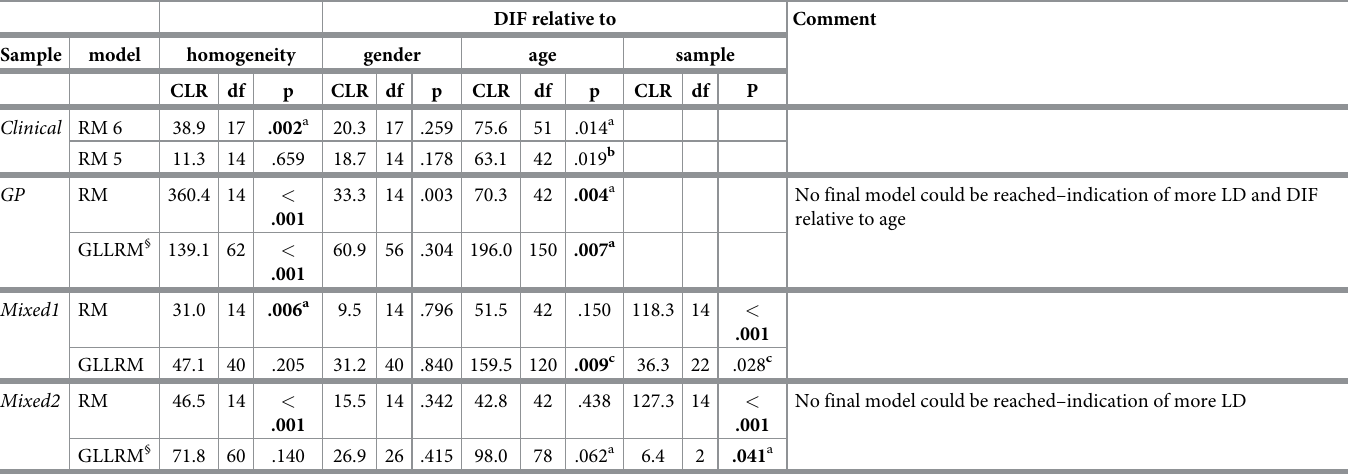
Table 5. TB-subscale (4 response categories): Global test-of-fit and global tests-of-no-DIF relative to gender, age group and